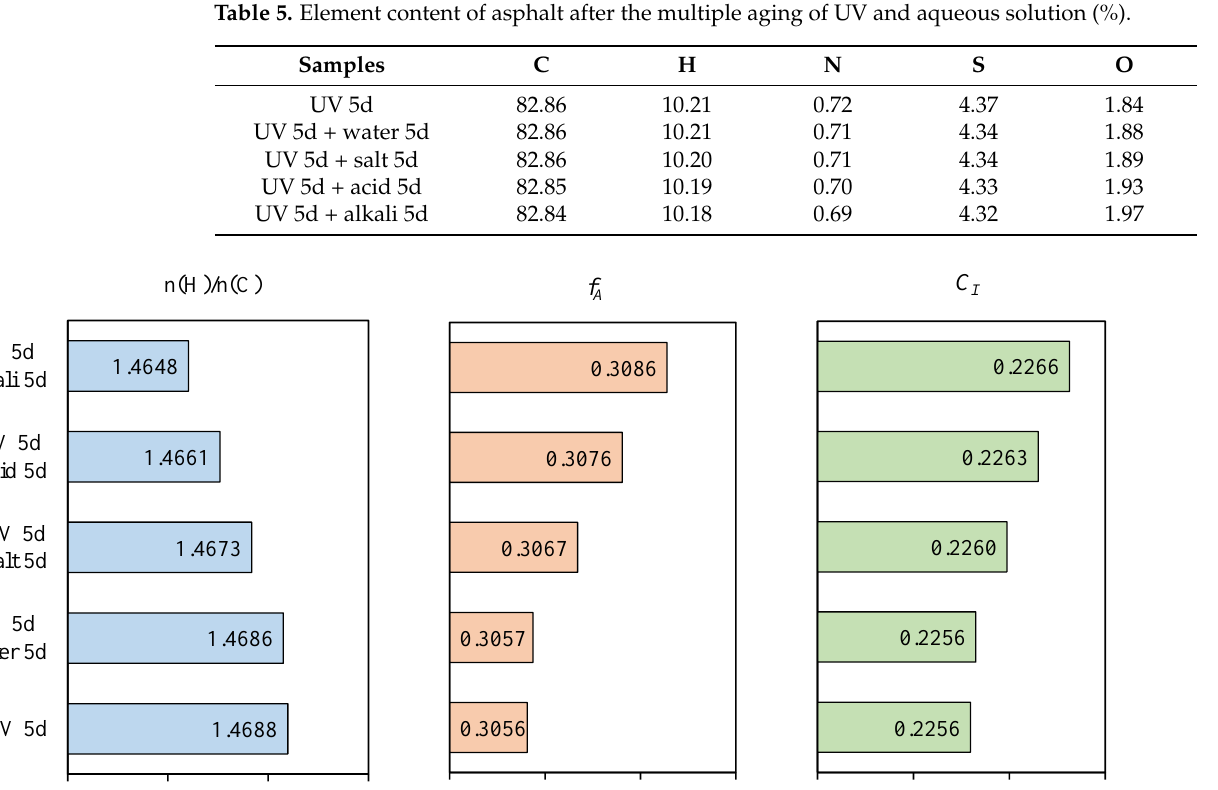
Table 4. Rangeability of C I after the multiple aging.